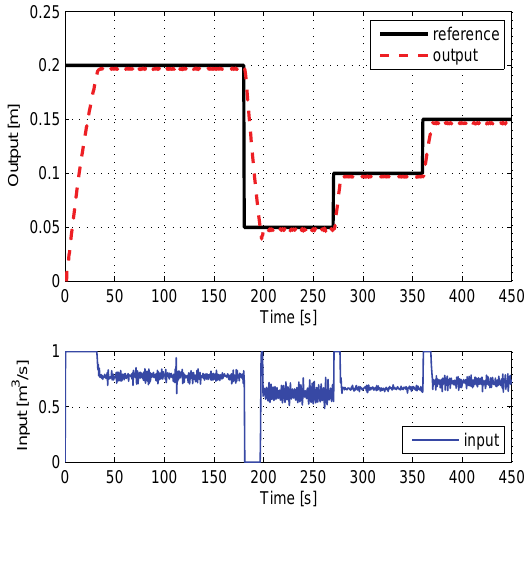
Fig. 5. Experimental results of the water level control in the first tank. The upper plot shows the output (water level). The lower plot reflects the corresponding input (control) signal.